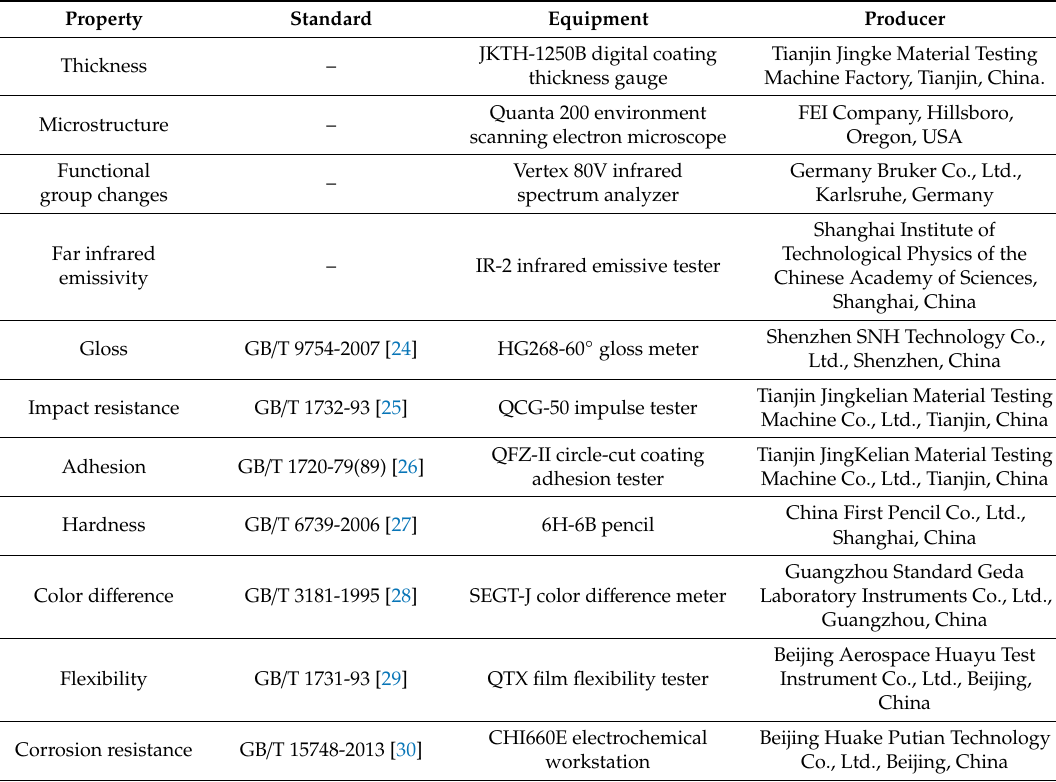
Table 2. Experimental test